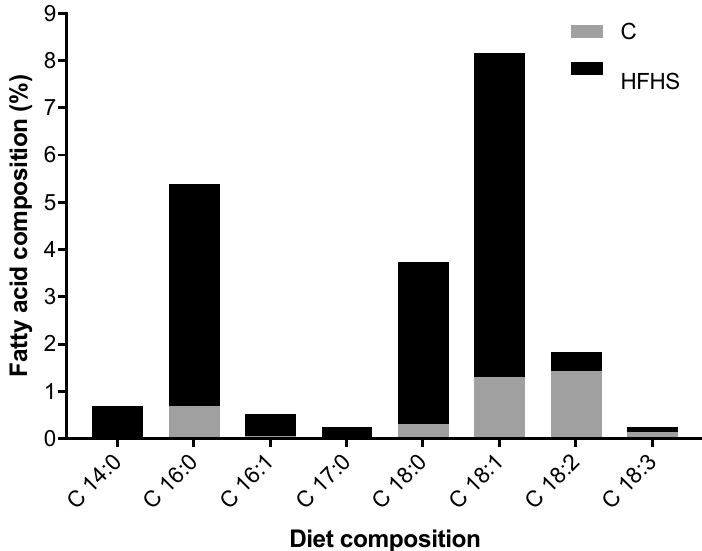
Figure 8. Proportion of fatty acid composition in the maternal diet.